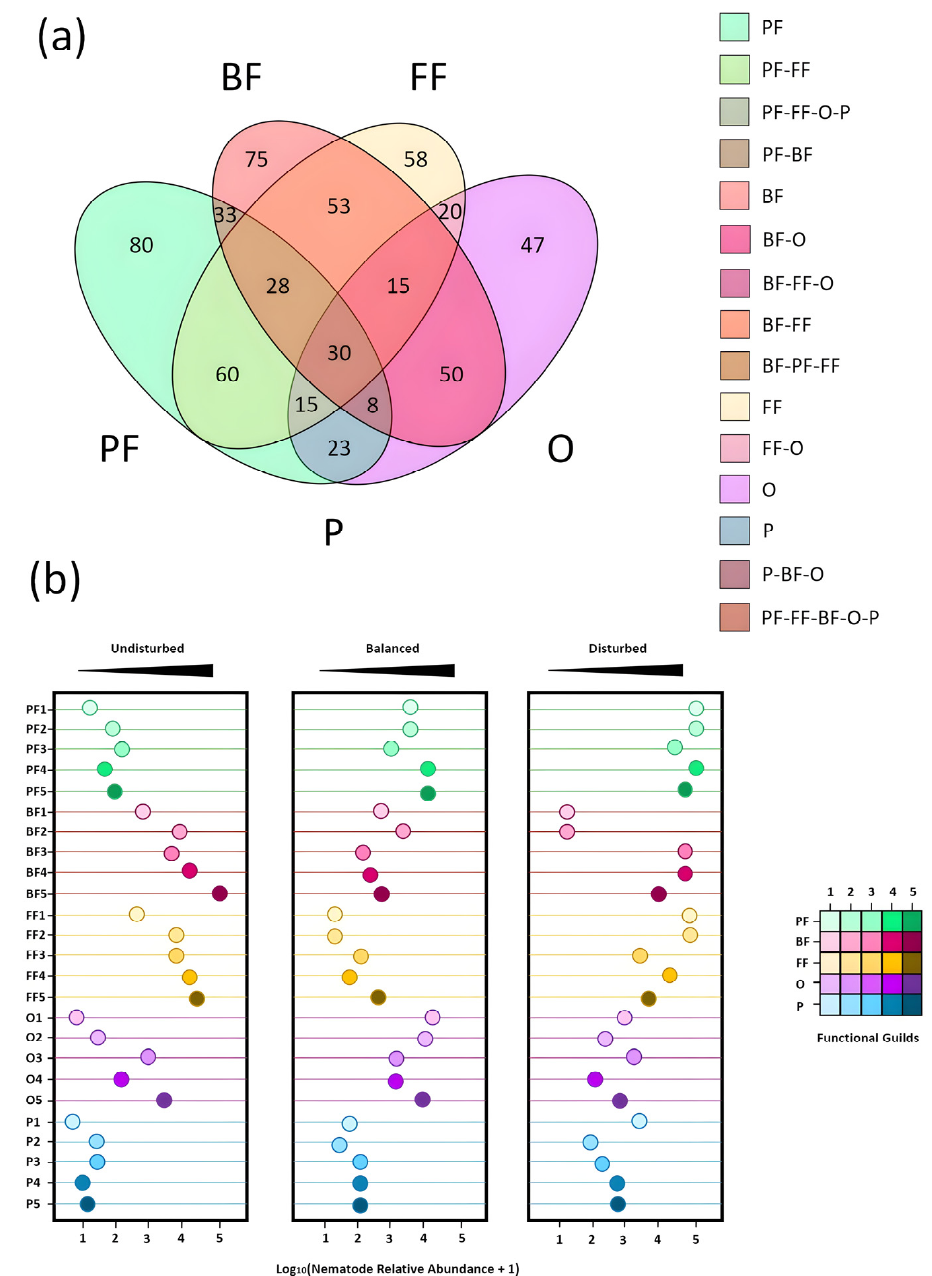
Figure 9. Functional guilds and trophic levels succession of soil nematodes on soil disturbance attributes in wheat fields. ( a ) Venn diagram depicting all nematode trophic levels successions. The numbers represent the weighted species richness percentage (WSRP) calculated in all surveyed areas. ( b ) Lollipop plot of nematode functional guilds (FGs) performance patterns for undisturbed, balanced, and disturbed soils. FGs were cube-space (5 × 5) organized and classified according to their trophic position (1 to 5 scaling). The plots were generated using BioPython matplotlib library via Matplotlib-venn [59] and Matplotlib-lollipop [60] modules in PyCharm